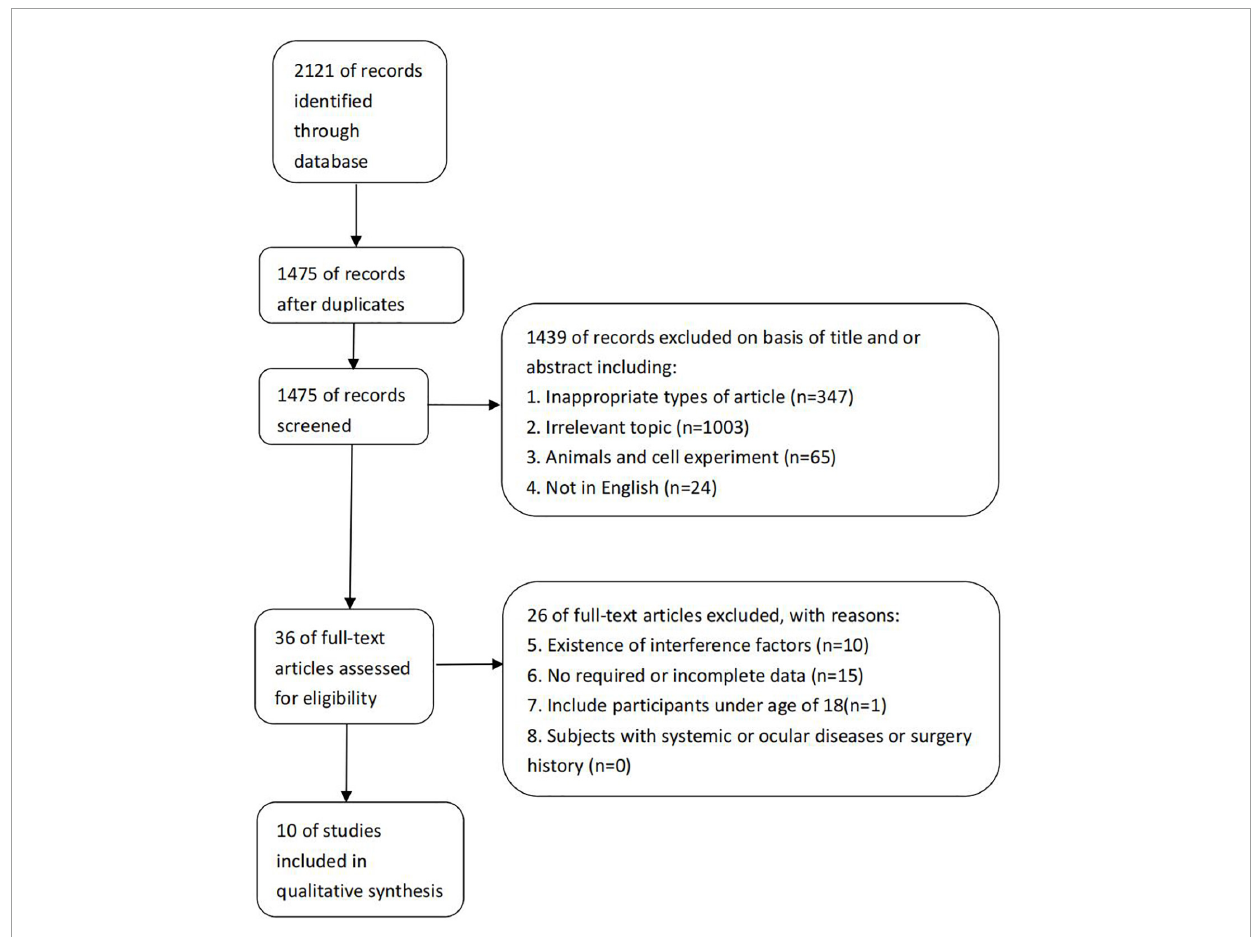
FIGURE1 Flow diagram of the studies selection